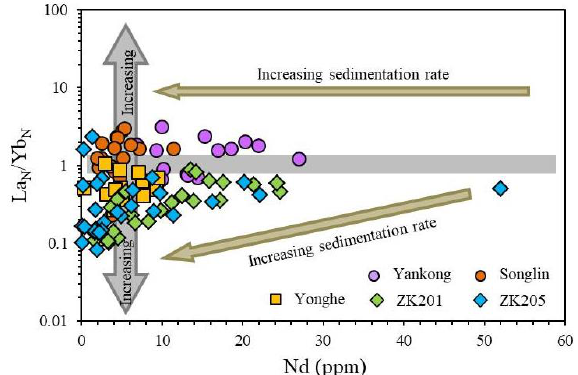
Figure 8. Plot of La N /Yb N versus Nd showing the sedimentation rate of the Early Cambrian black shale.